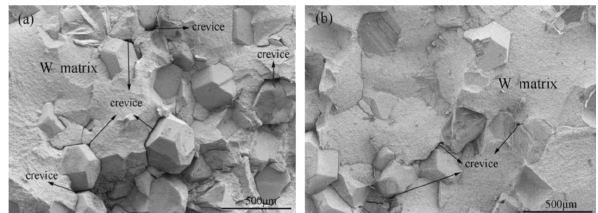
Figure 9. Microstructure of fractured surfaces: ( a ) uncoated and ( b ) coated. Reprinted with permis- sion from Ref. [45]. Credit c (cid:13) Elsevier,